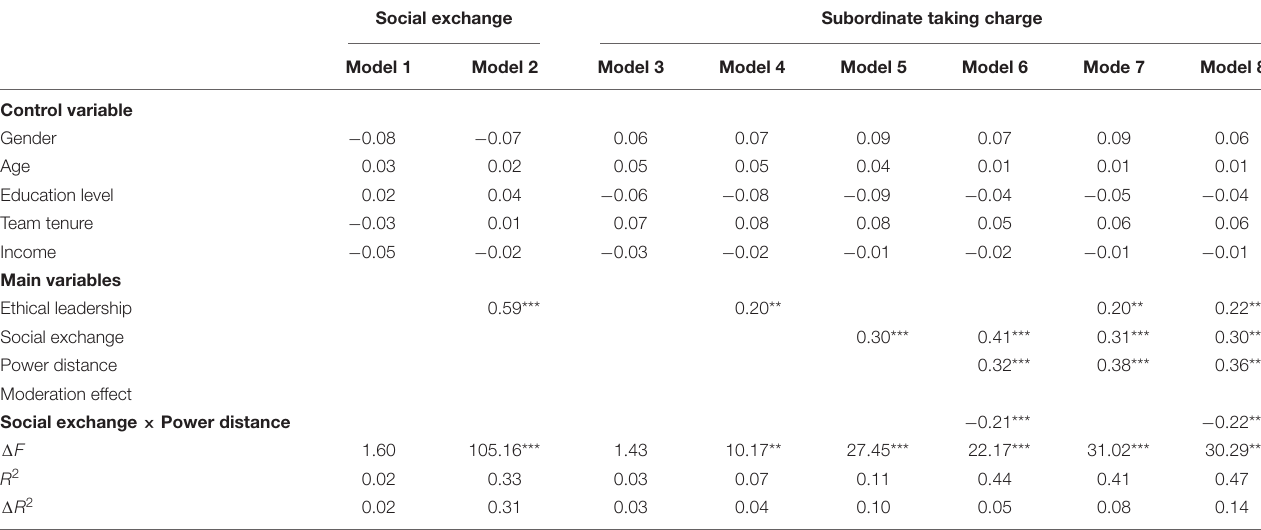
TABLE 4 | Hierarchical multiple regression analysis.